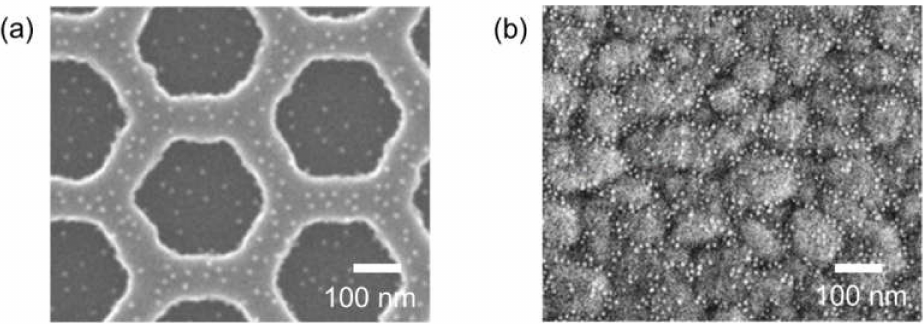
Figure 8. SEM images of ( a ) the channel and ( b ) the gate electrode with the immobilization of AuNPs (diameter: 10